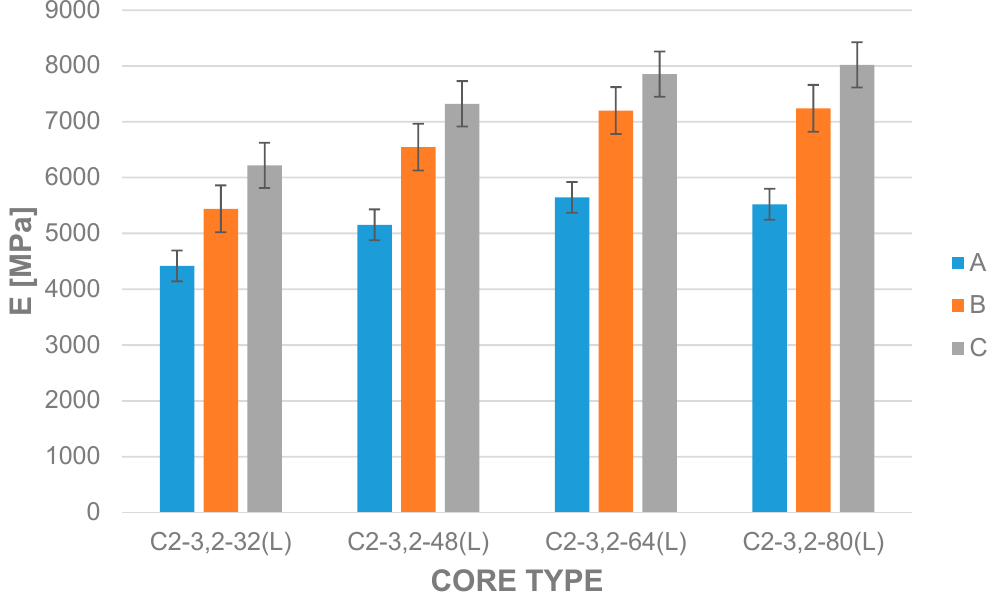
Figure 10. Influence of honeycomb density (32, 48, 64, 80) kg · m − 3 on the bending modulus of sandwich constructions A–C (L orientation).